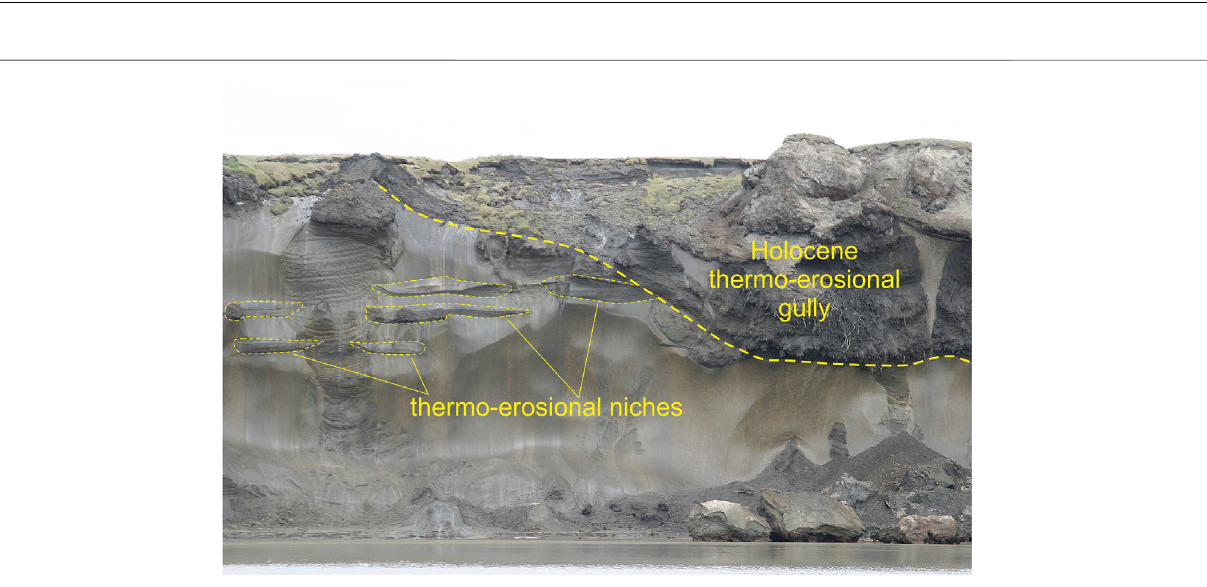
Frontiers in Earth Science |